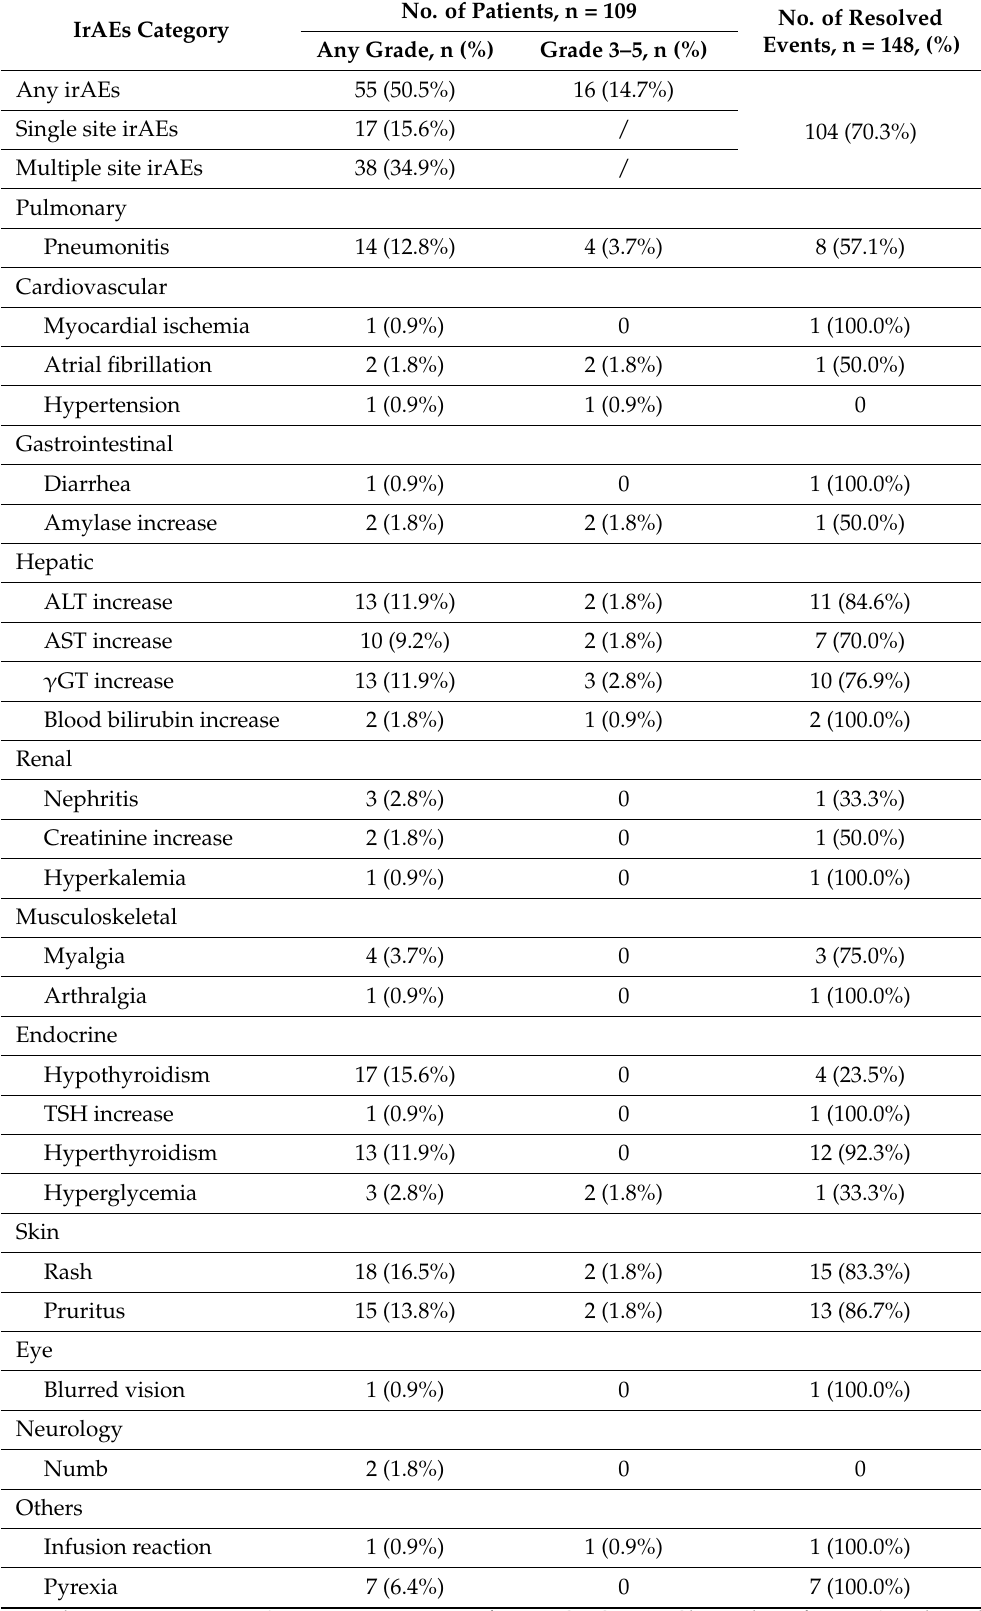
Table 2. Immune-related adverse events (irAEs) by characteristics and resolution rates. IrAEs